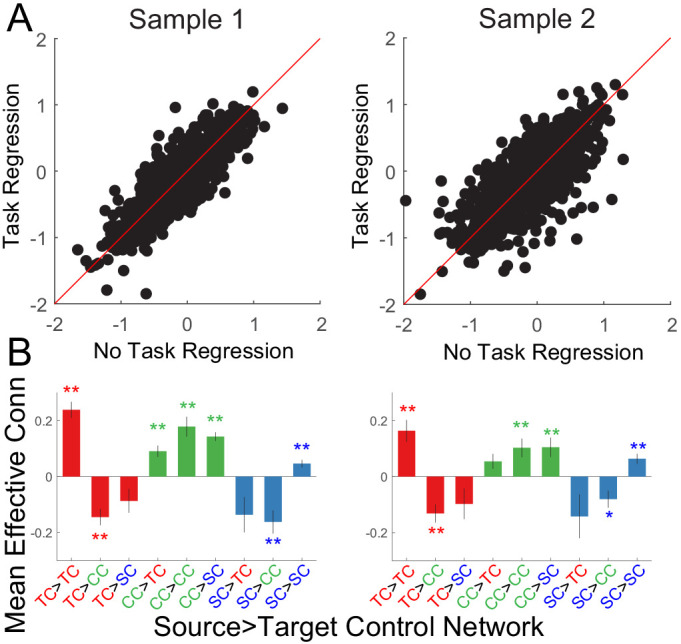
Effect of task signals on effective connectivity parameters and source x network interactions.(A) Comparison of effective connectivity parameters with and without regressing out task signals. Bias (e.g. task-induced increases) would be apparent as a shift off of the diagonal (red line). No bias was observed. (B) Source x target network interactions after regressing out task signals. The same interaction was observed after regressing out task signals as was observed in the main text indicating that the interactions were not driven by task signals.